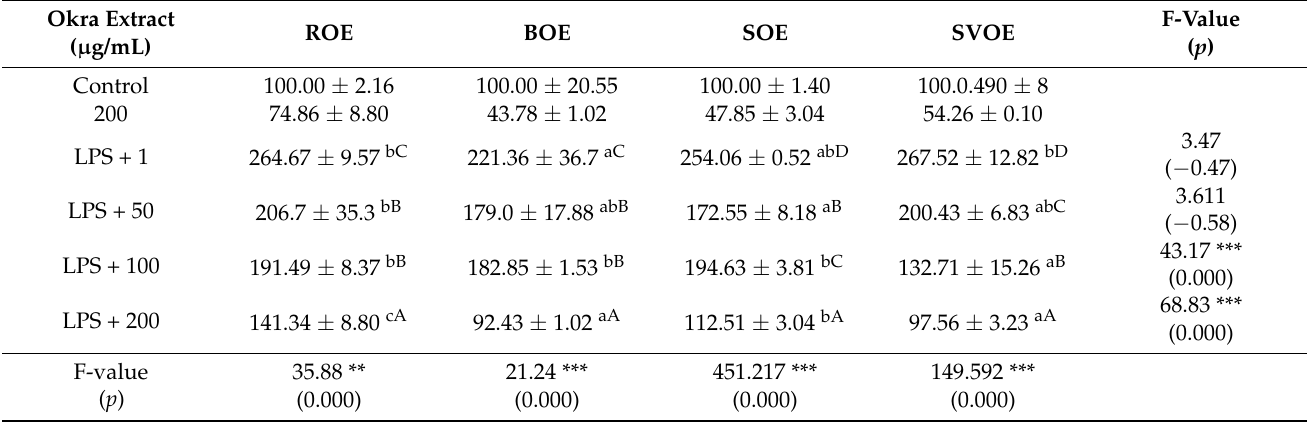
Table 2. Effect of okra extract on nitric oxide (NO) production in LPS-induced RAW264.7 cells. Okra Extract